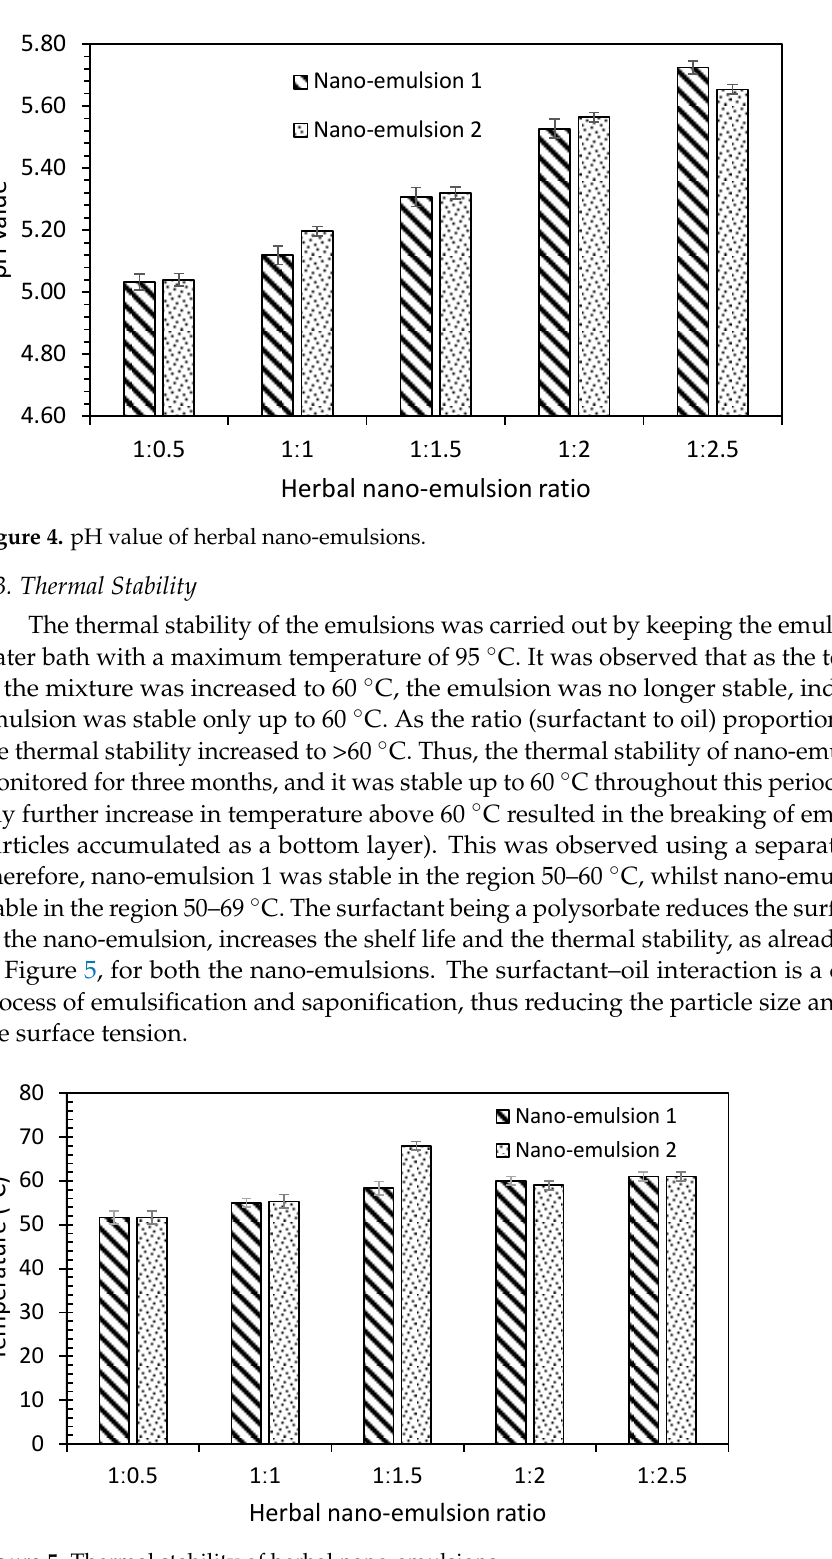
Figure 5. Thermal stability of herbal nano-emulsions.